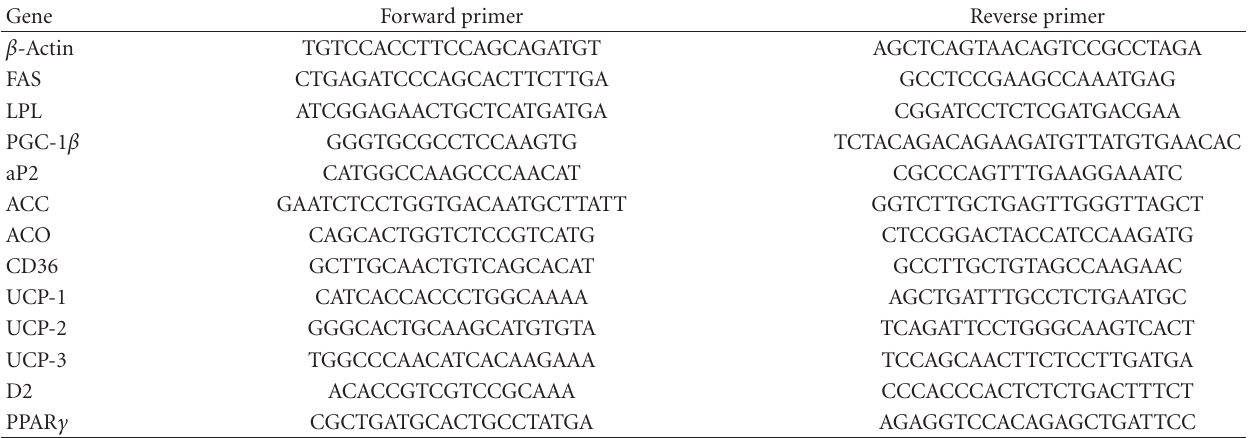
Table 1: Sequences of the primers used in real-time